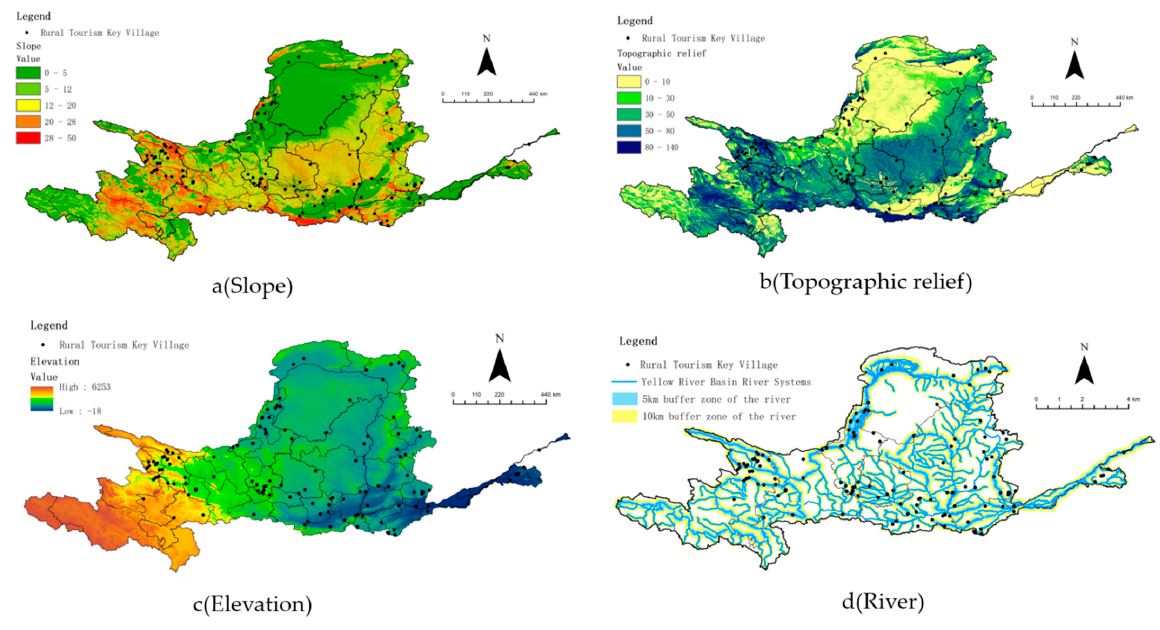
Figure 7. Distribution of natural factors in key rural tourism villages in the Yellow River